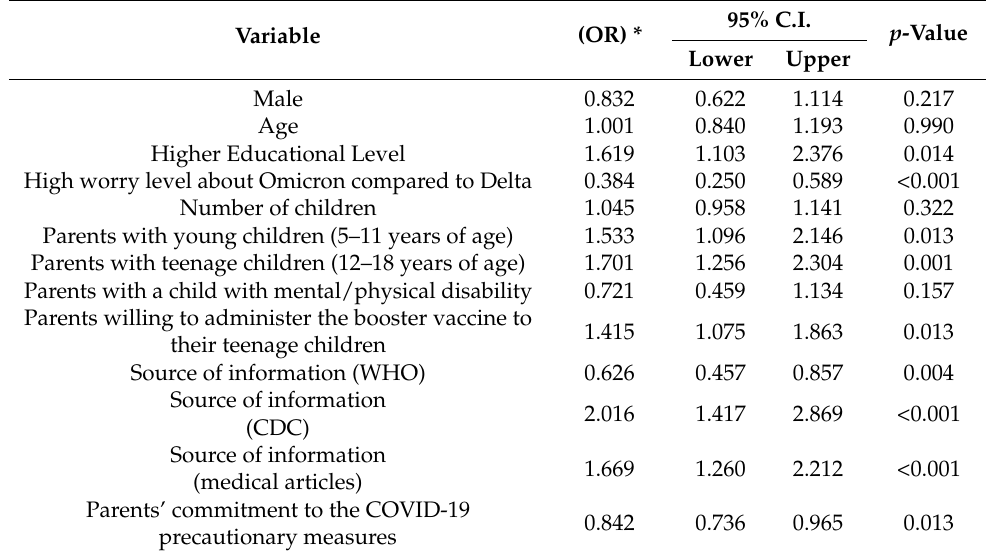
Table 5. Multivariable Logistic Regression Analysis of parents’ odds of agreeing to send their children to school despite the presence of a COVID-19 outbreak in